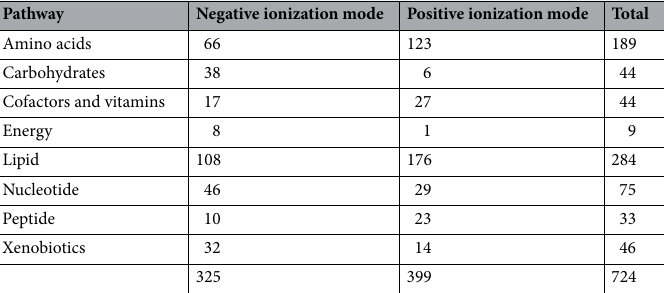
Table 2. Classification of metabolites identified in western corn rootworm larvae fed on Bt-expressing maize lines compared to feeding on the non-Bt maize control line.